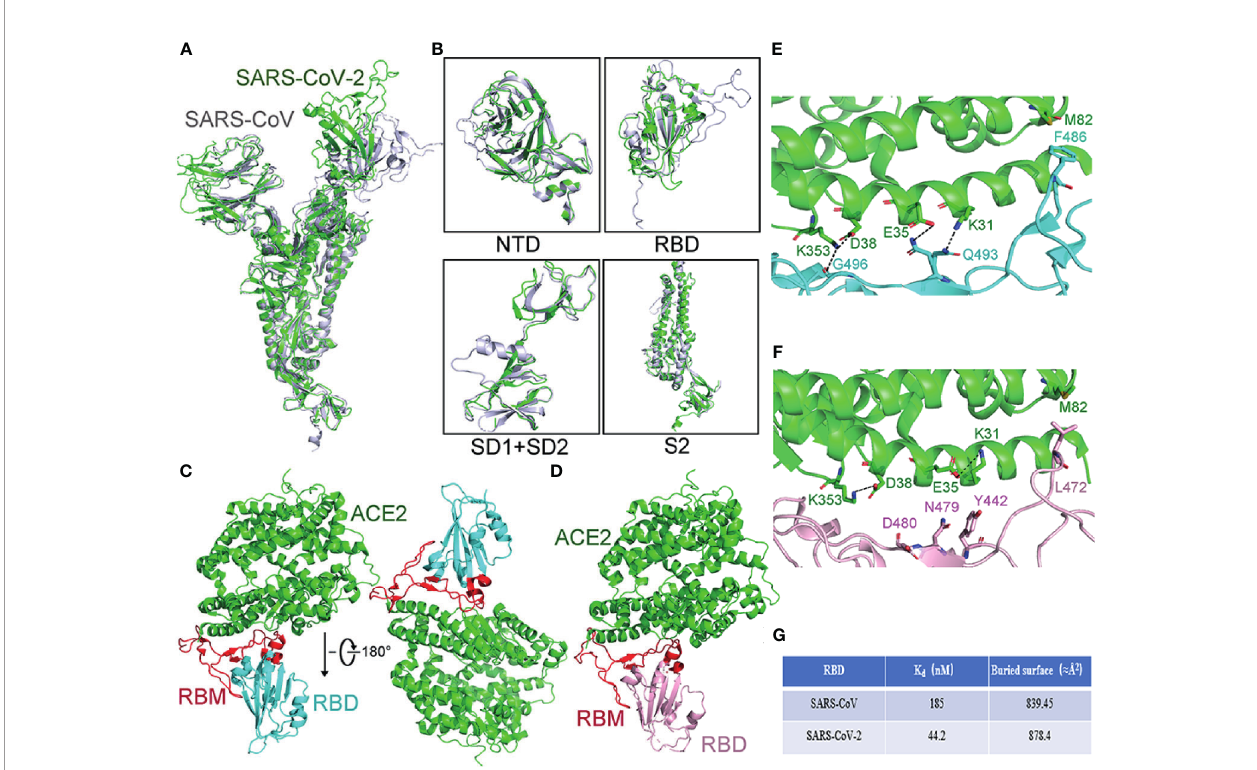
FIGURE 7 | Comparison of the S protein in SARS-CoV-2 and SARS-CoV. (A) Compared whole S protein between SARS-CoV-2 and SARS-CoV. SARS-CoV-2 and SARS-CoV are shown in green and gray, respectively. (B) Compared different domains of S protein between SARS-CoV and SARS-CoV-2. Structural domains from SARS-CoV-2 S protein have been aligned with the domain from SARS-CoV S as follows: NTD (top left), RBD (top right), SD1, and SD2 (bottom left), and S2 (bottom right). SARS-CoV and SARS-CoV-2 are shown in gray and green, respectively. (C) The overall structure of the SARS-CoV-2 RBD with ACE2 from the side view. ACE2 is shown in green. The SARS-CoV-2 RBD is shown in cyan and RBM in red. (D) The overall structure of the SARS-CoV RBD with ACE2 from the side view. The SARS-CoV RBD is shown in pink and RBM in red. ACE2 is shown in green. (E) The structural details of the interface between ACE2 and SARS-CoV-2 RBM. The interface between the SARS-CoV-2 RBM and ACE2 has been shown. The SARS-CoV-2 RBM is shown in cyan. ACE2 is shown in green. (F) The structural details of the interface between ACE2 and SARS-CoV RBM. The interface between SARS-CoV RBM and ACE2 has been shown. ACE2 is shown in green. The SARS-CoV RBM is shown in pink. (G) Compared Kd value and buried surface between the SARS-CoV RBD or SARS-CoV-2 RBD with ACE2. The value buried area is calculated as the average value. All structures are drawn by